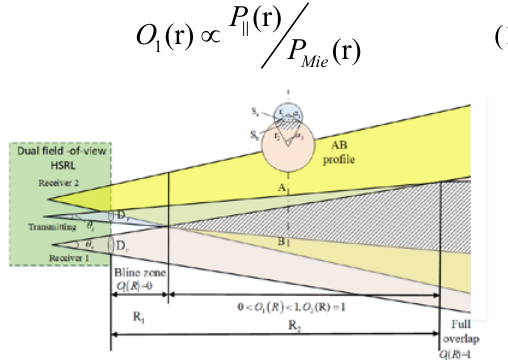
Fig.2 The schematic view of dual